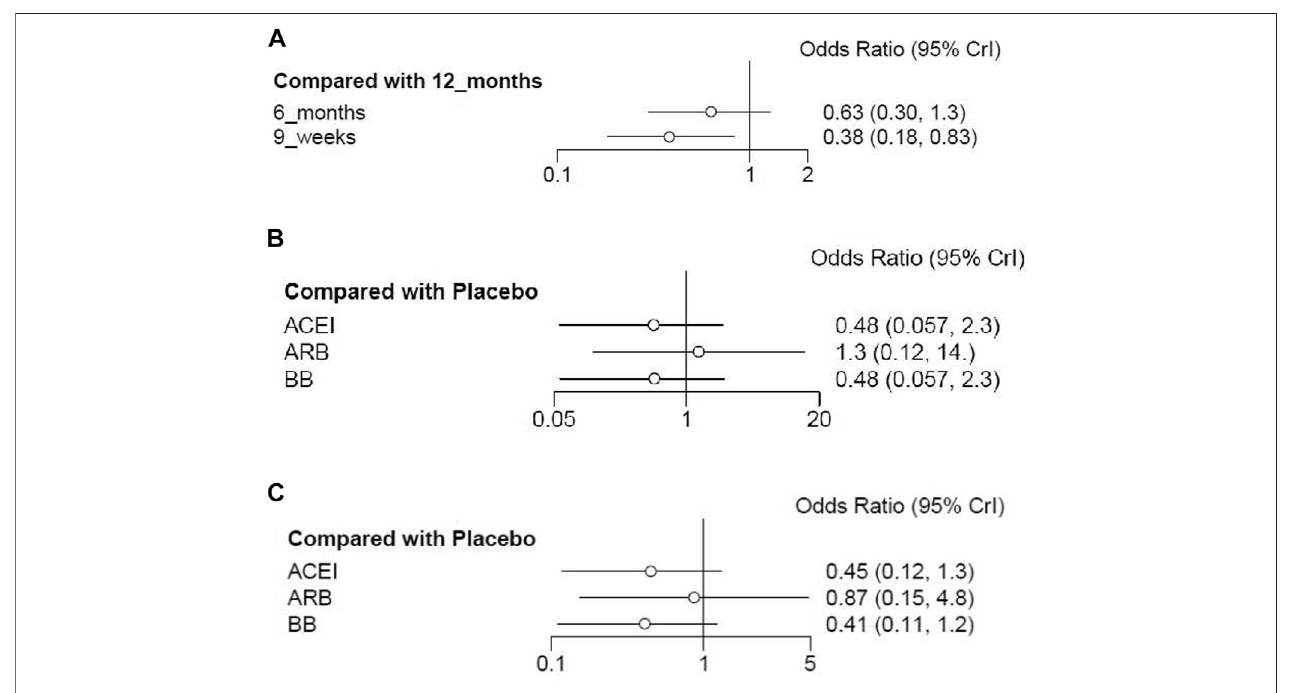
FIGURE 3 | Forest plots of the effect of interventionsfor reducing cardiotoxicity in breast cancer patients receiving trastuzumab. (A) Short duration oftrastuzumab usingcardiotoxicityastheoutcome; (B) cardioprotective druginterventionusingcardiotoxicityastheoutcome; (C) cardioprotectivedruginterventionusinginterruptions in trastuzumab therapy as the